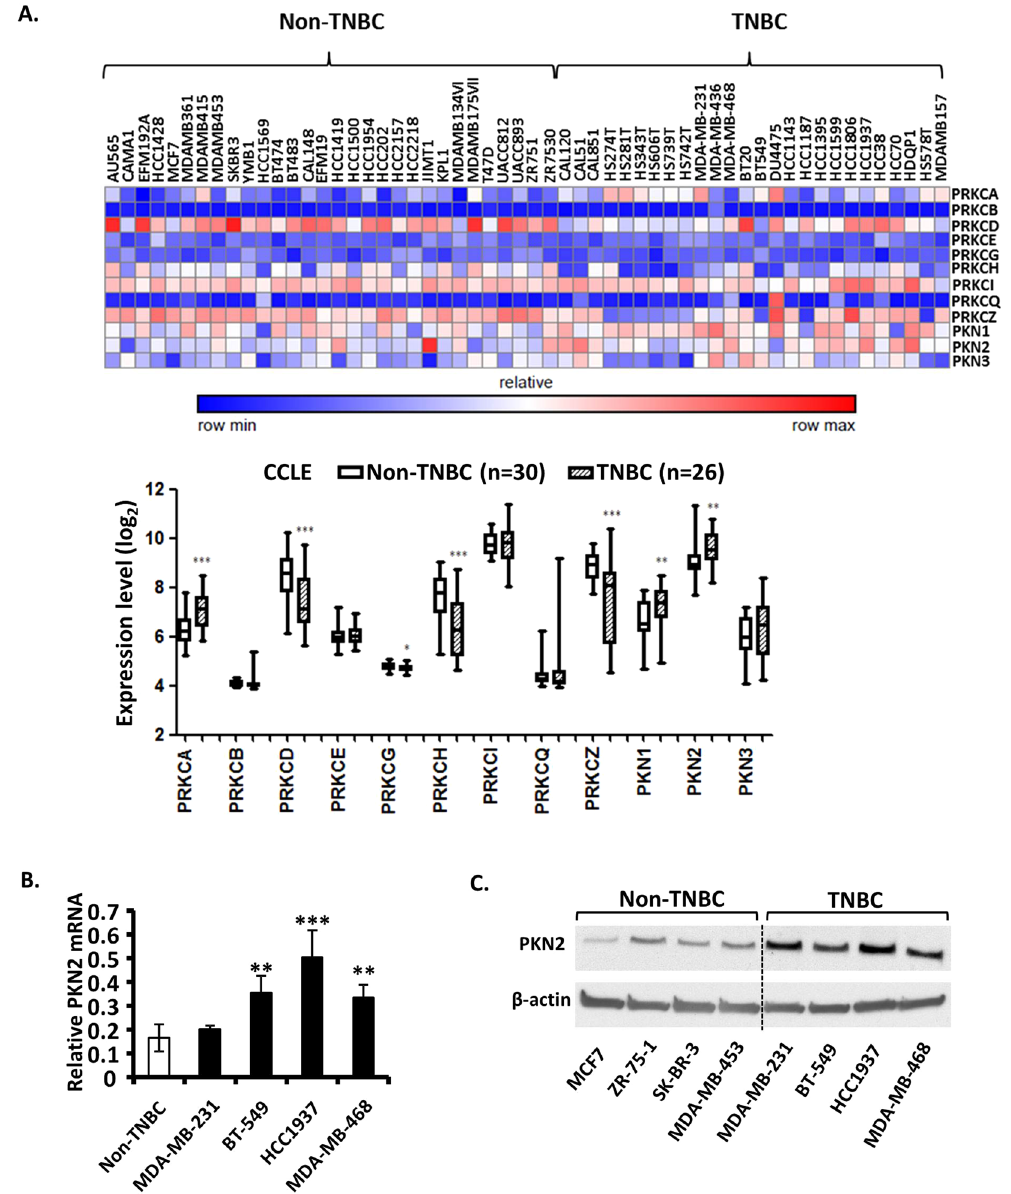
Figure 3. PKN2, one of PKC isozymes, is highly expressed in TNBC cells. ( A ) Relative mRNA expression levels (log 2 ) of 12 PKC isozymes in human breast cancer cell lines from Cancer Cell Line Encyclopedia (CCLE) database (n = 56). The heatmap represents color-coded expression levels of differentially expressed PKC isozymes in human breast cancer cell lines. The color scale ranges from saturated blue for the minimum to saturated red for maximum. Average values in the graph are the mean value of all the non-TNBC cell lines (n = 30) and TNBC cell lines (n = 26). ( B ) Quantitative real-time PCR analysis of PKN2 in four non-TNBC cell lines (average value of four cell lines is shown) compared with four TNBC cell lines (individual value of each cell line is shown). Average values are from three independent experiments performed in duplicate (n = 3). ( C ) Western blotting analysis of PKN2. Data are shown as mean ± SD. P-values determined by Student’s t-test compared to non-TNBC cell lines. * P < 0.05; ** P < 0.01; *** P <